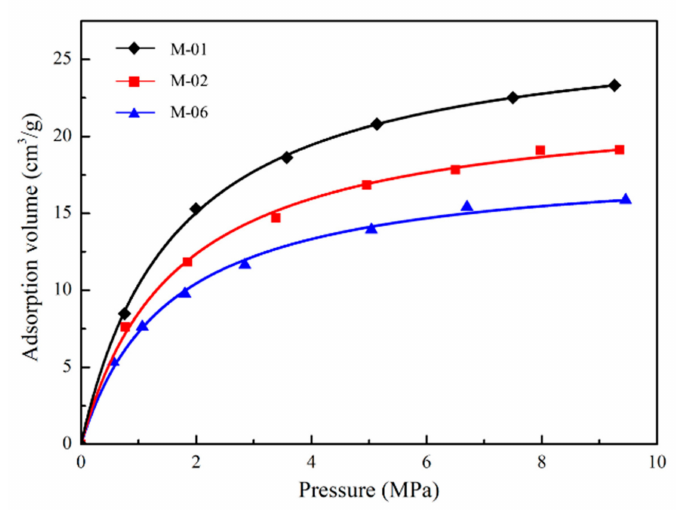
Figure 8. Isothermal adsorption curves of di ff erent pore structure samples.